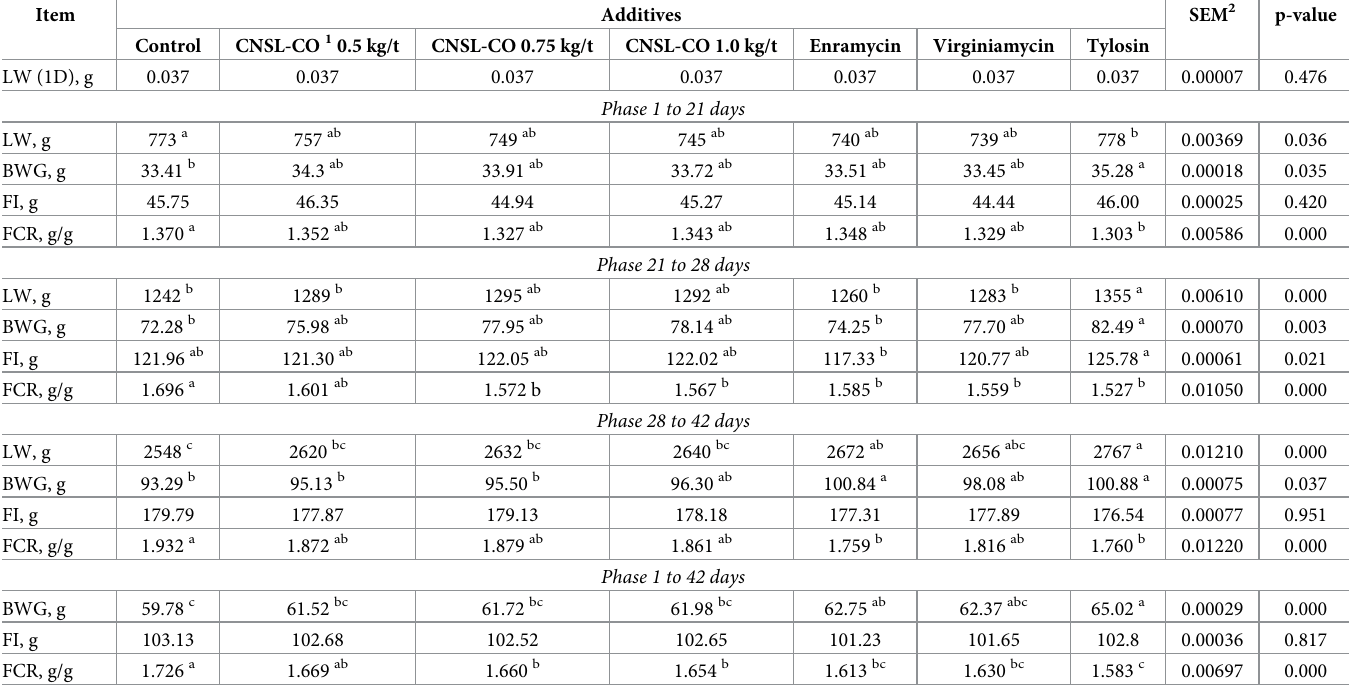
Table 1. Live weight (LW), body weight gain (WG), feed intake (FI), and feed conversion ratio (FCR) of challenged broilers from 1 to 42 d of age.